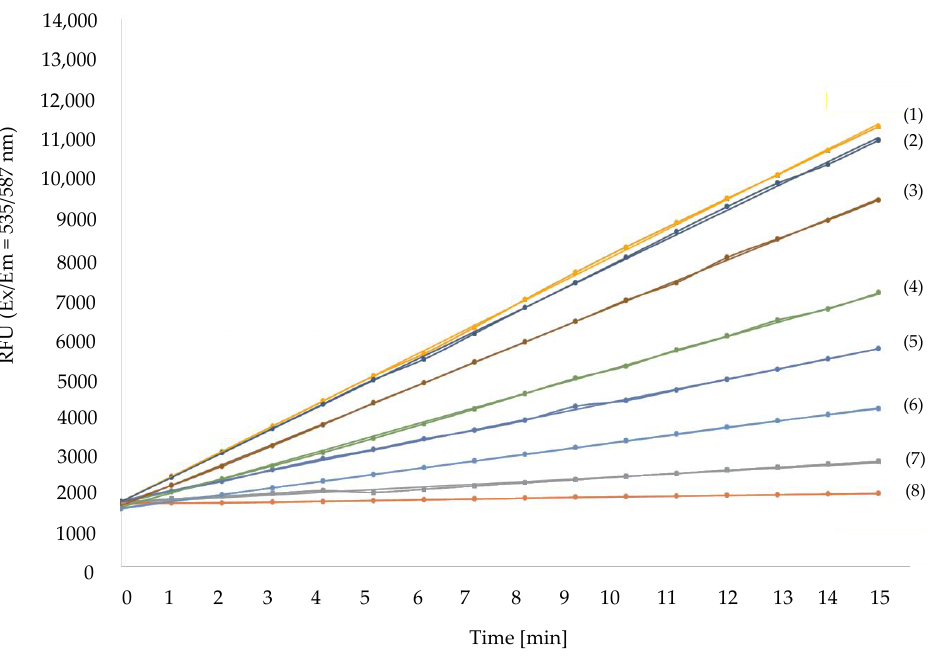
Figure 3. Kinetics of MAO-A enzymatic activity. The assay presented a fluorimetric detection of H 2 O 2 at different concentrations (0.1 ÷ 1000 nM) of clorgyline during the oxidative deamination of MAO-A substrate. The measurement of fluorescence (Ex/Em = 535/587 nm) occurred kinetically at 25 ◦ C for 15 min. Curve (1) corresponds to no addition of the inhibitor, whereas in all other samples (2–8) the inhibitory concentration was augmented gradually. The slope of every curve was an indicator of the enzymatic reaction. The greater the slope was, the higher the rate of MAO-A activity was detected. Based on the obtained percentages for the decrease in MAO-A activity after the ad- ministration of different inhibitor concentrations, we constructed a concentration-response curve of the MAO-A relative activity in %, illustrated in Figure 4. Furthermore, the same curve enabled the calculation of the inhibitory concentration corresponding to the respec- tive enzymatic activity.